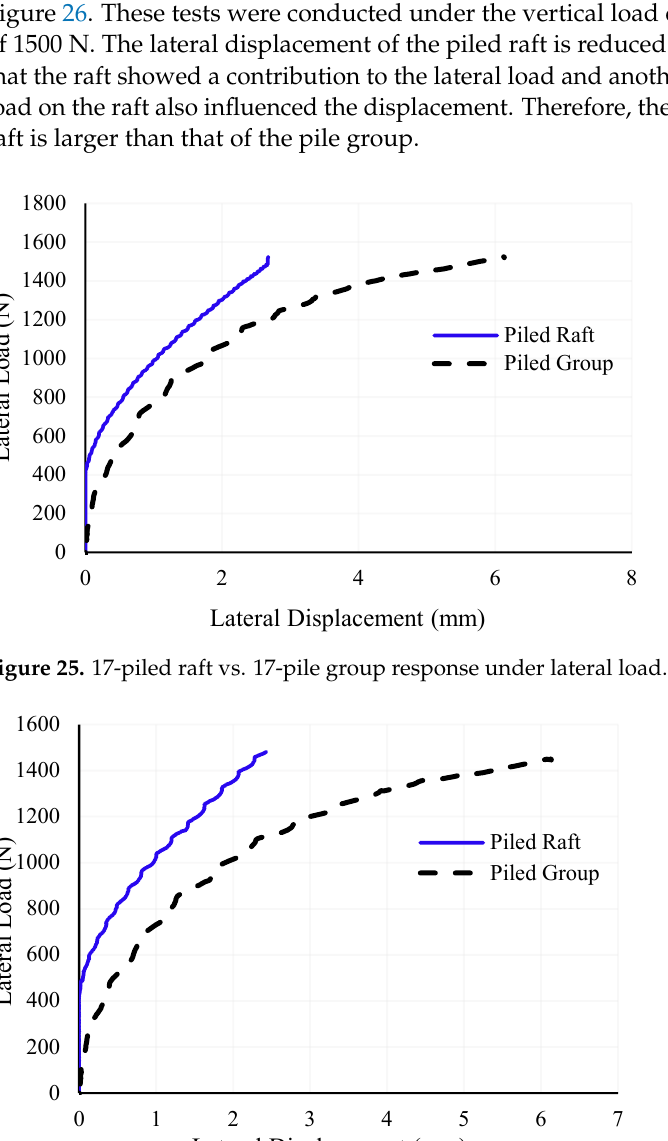
Figure 24. 13-piled raft vs. 13-pile group response under lateral load.